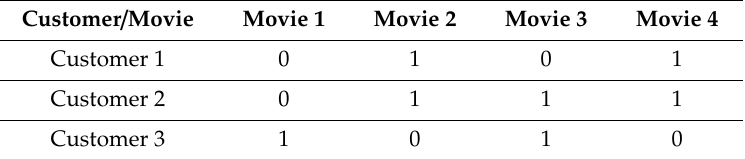
Table 4. Relevant information about the customers and